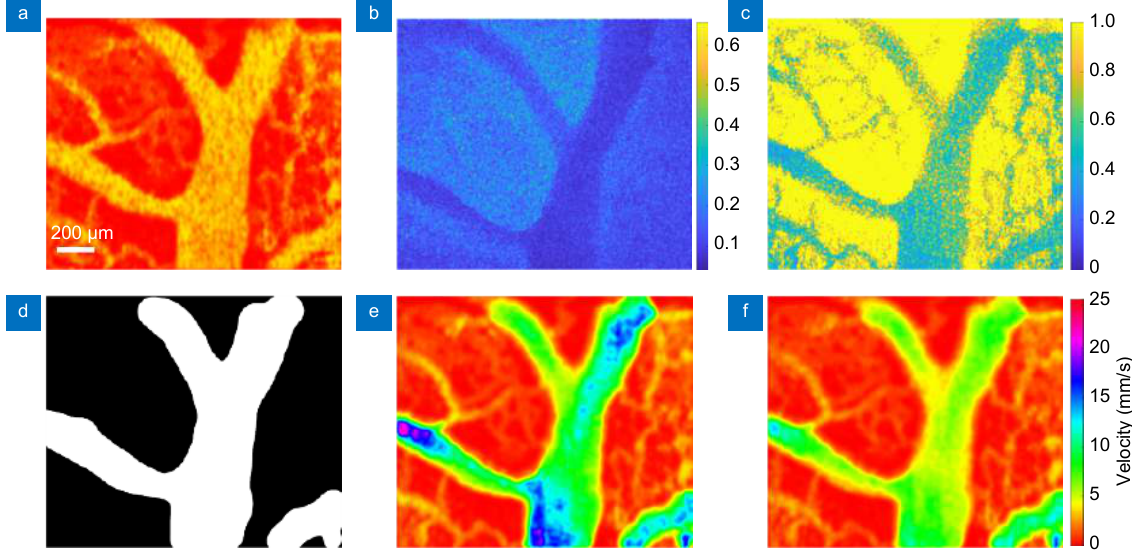
Fig. 6 | LS-LSAI/SI-LSCI image fusion. ( a ) A LS-LSAI flow image. ( b ) The speckle contrast image of the same FOV acquired by SI-LSCI. ( c ) The normalized version of (b) with the β map from LS-LSAI. ( d ) A big vessel mask derived from (a). ( e ) and ( f ) Merged flow images at t =1 s and t =1.47 s, respectively. The same color map and color bar apply to (a), (e), and